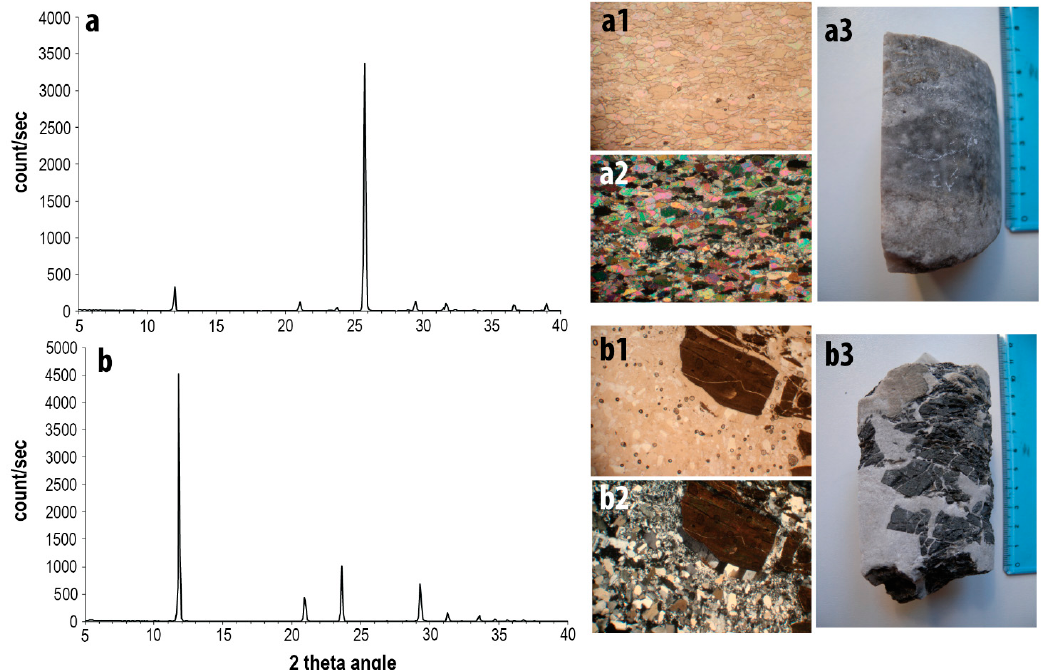
Figure 7. X-ray powder diffractograms of the analysed samples. ( a ) evaporite fragment in PZ22, showing the presence of anhydrite; ( a1 , a2 ) thin section of fragment from PZ22, parallel nicols above and cross nicol below showing the dense structure of the anhydrite; ( a3 ) the evaporite sample used for thin section consisting of rhythmic alternations of thin gypsum and anhydrite layers (withe) interspersed with marls and clayey layers (black); ( b ) evaporite sample in PZ3, showing the presence of gypsum; ( b1 , b2 ) thin section of fragment